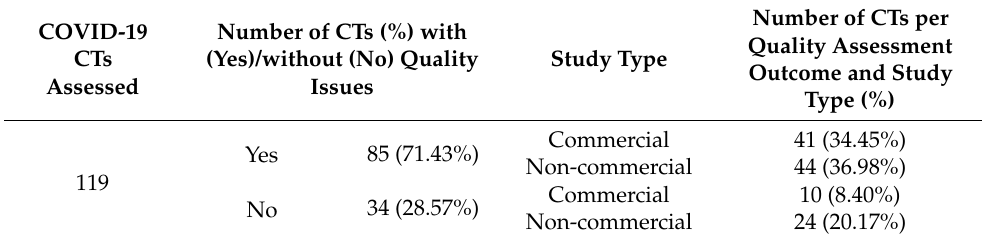
Table 1. COVID-19 CTs assessed from March 2020 to March 2021 and their quality assessment outcome per study type.